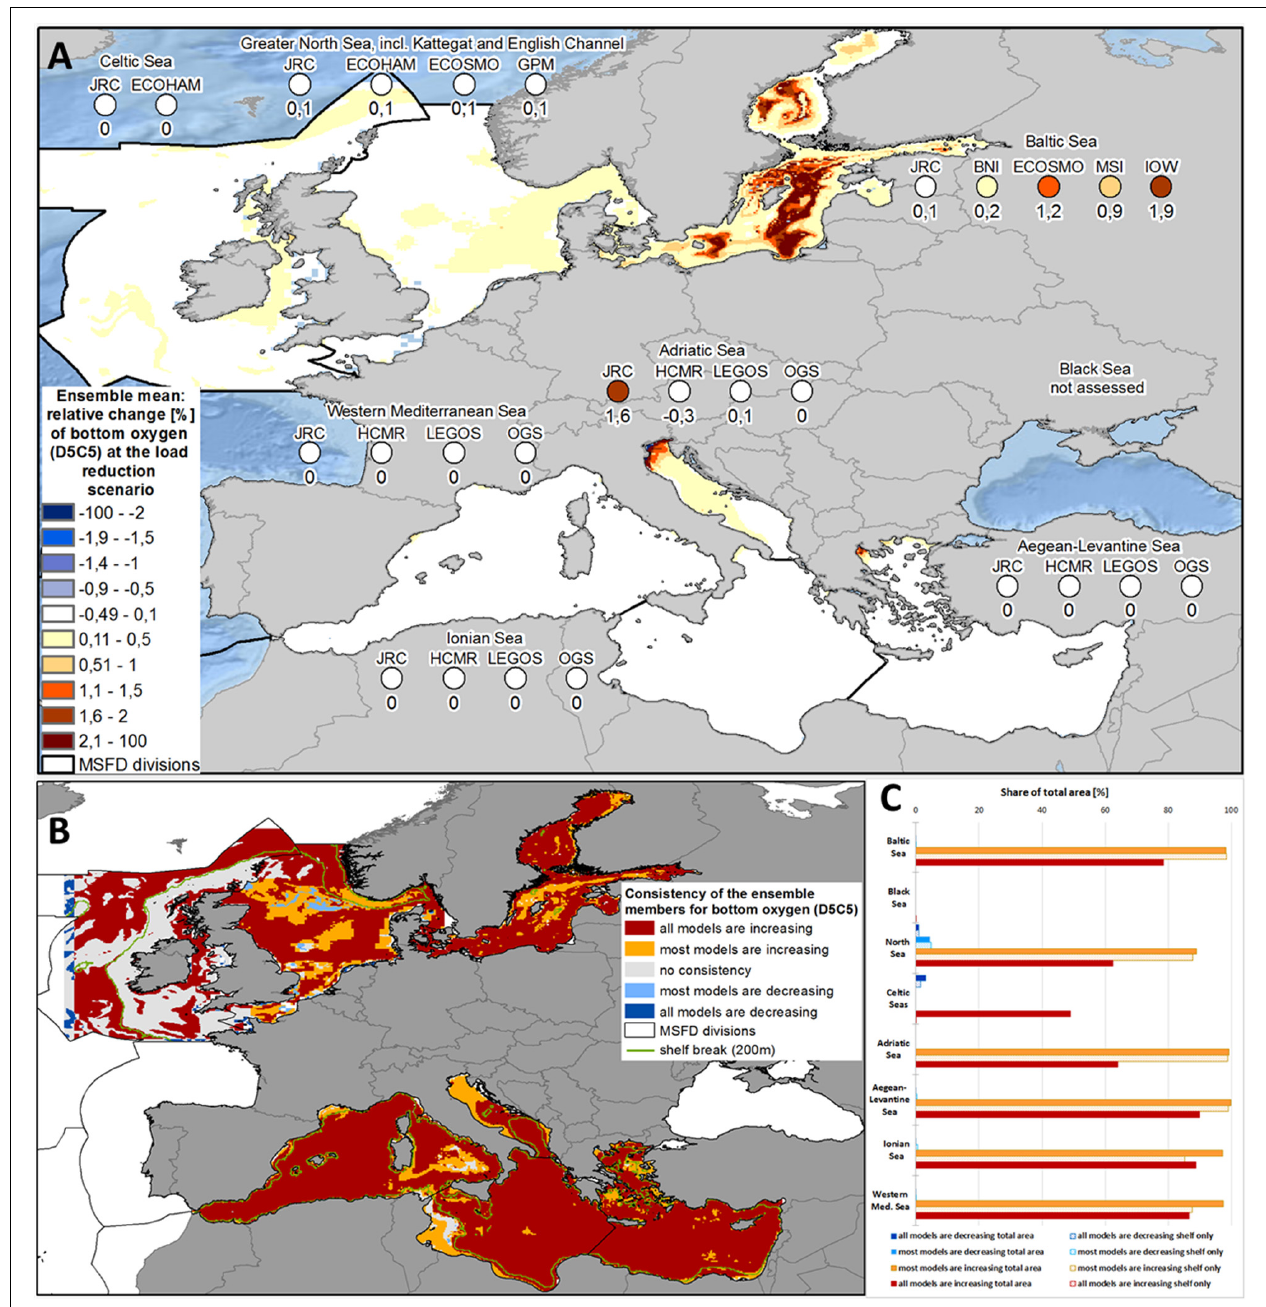
FIGURE 7 | (A) Ensemble means and model-specific relative change at load reduction scenario (compared to reference scenario) for the MSFD regions of bottom oxygen (MSFD indicator D5C5) [please be aware that increased values of bottom oxygen are indicating an improved ecosystem status]. (B) Consistency map showing, if all or at least most models have the same trend of the relative change at load reduction scenario (compared to reference scenario) with respect to bottom oxygen (MSFD indicator D5C5). (C) Share of the total area (bold bars) and of the shelf region (dotted bar), where all or most models show consistent changes with respect to bottom oxygen (MSFD indicator